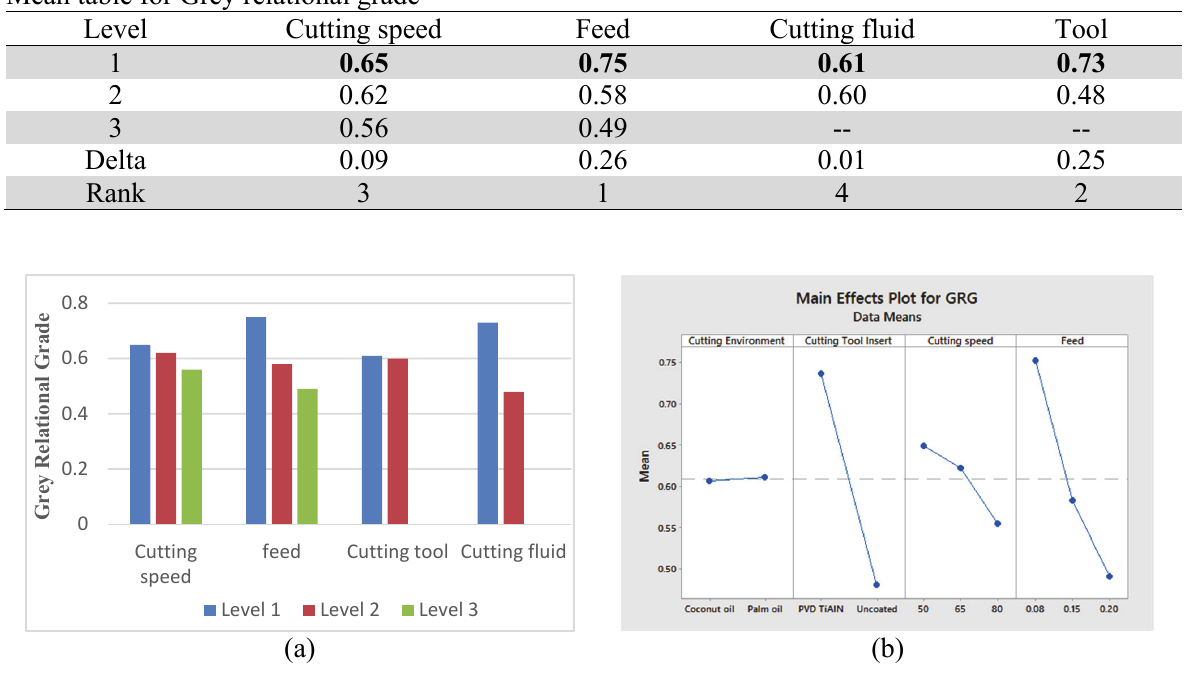
Fig. 4. (a) Effect of process parameters on grey relational grade and (b) Main effect plot for